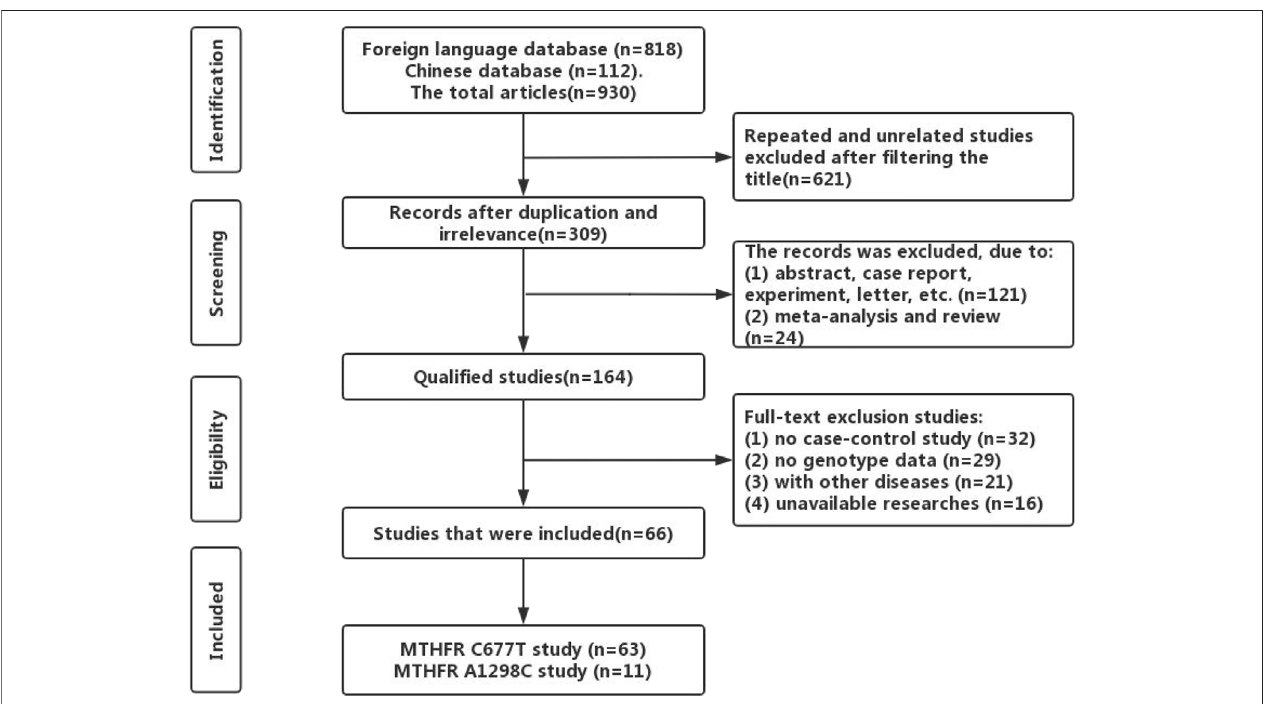
FIGURE 1 | Flow chart of literature selection for the current